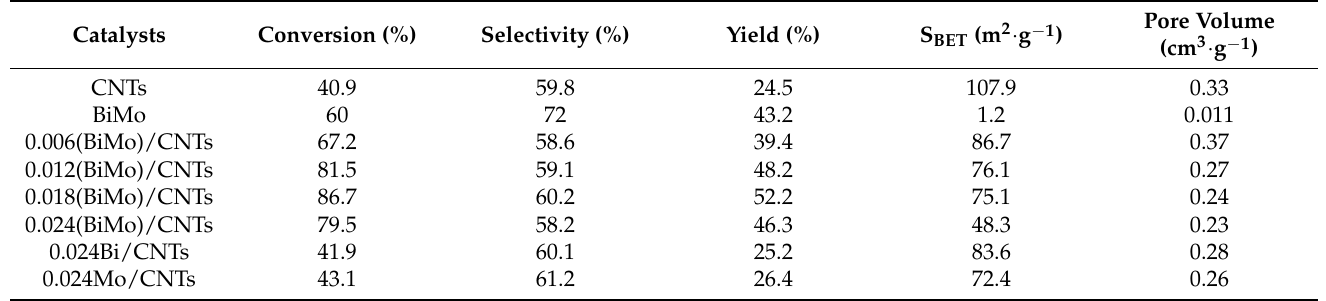
Table 1. BET surface area, total pore volume, and catalytic performance of CNT catalysts with different compositions in the absence of